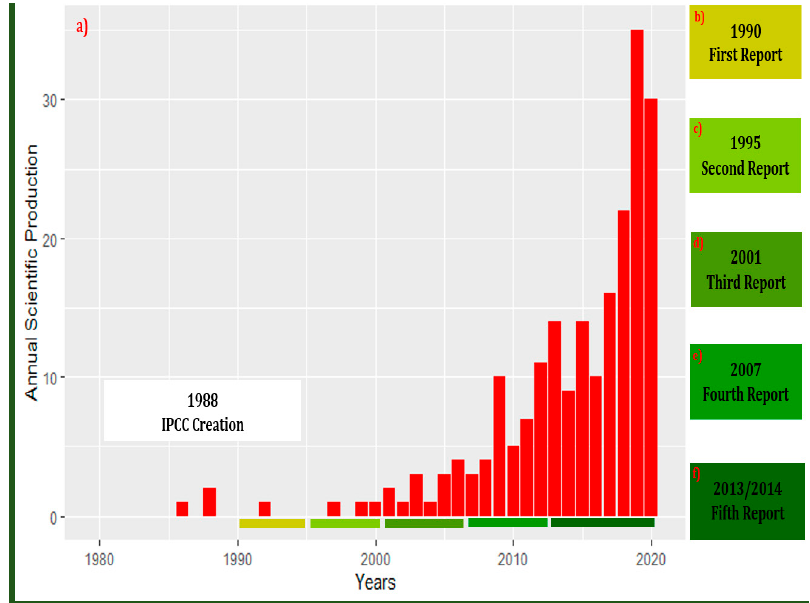
Figure 5. ( a ) Growth in total publications in the Scopus collection and Google Scholar from 1980 to 2000, showing the publication of ( b ) The IPCC Second Assessment Report (SAR); ( c ) the Second Assessment Report; ( d ) the Third Assessment Report; ( e ) the Fourth Assessment Report; ( f ) the Fifth Assessment Report.